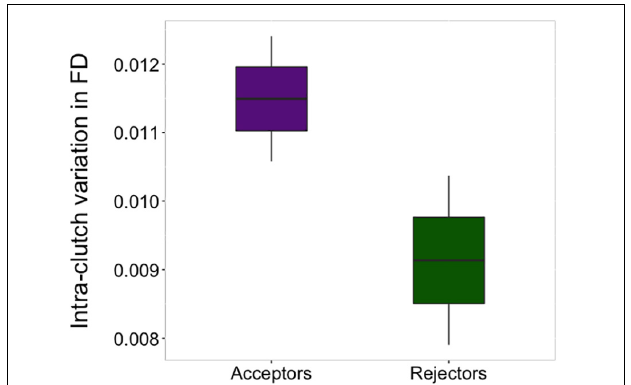
FIGURE 4 | Differences in intra-clutch variation in the fractal dimension between acceptor and rejecter magpies. Horizontal line represents the mean value, boxes standard error and line bars that indicate confidence intervals (95%).